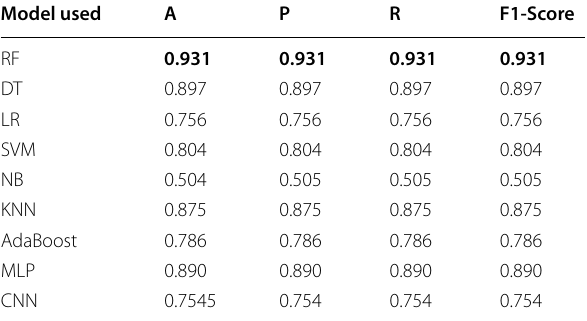
Table 4 Results without Proposed Feature vector generation Model used